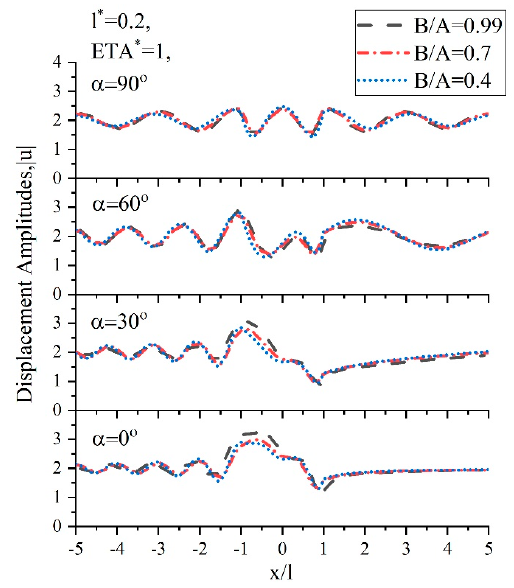
Figure 9. Comparison of displacement amplitudes of canyons belonging to ellipses with different axial ratios when l ∗ = 0.2 and ETA ∗ =